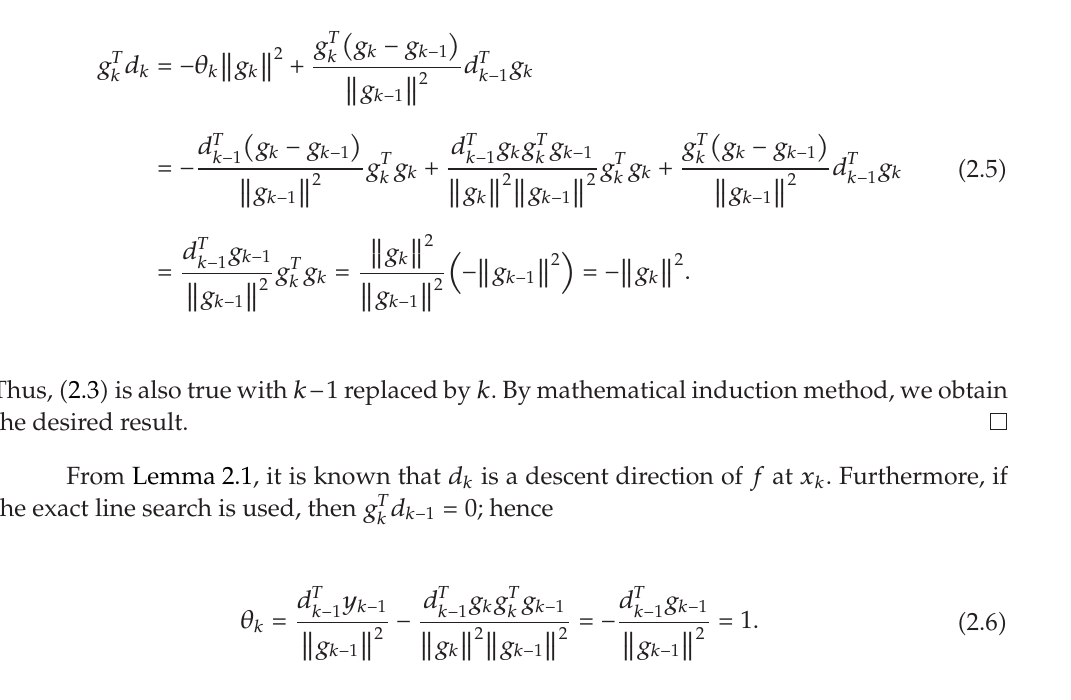
Algorithm 2.2 (cid:5) Modified Spectral PRP Conjugate Gradient Algorithm (cid:6) . We have the following